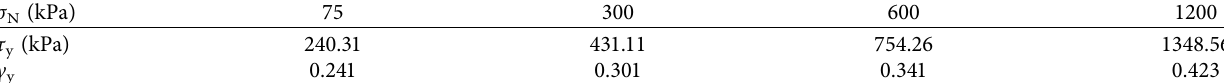
Table 3: The theoretical shear stress and shear strain of the contact surfaces at the yield point.